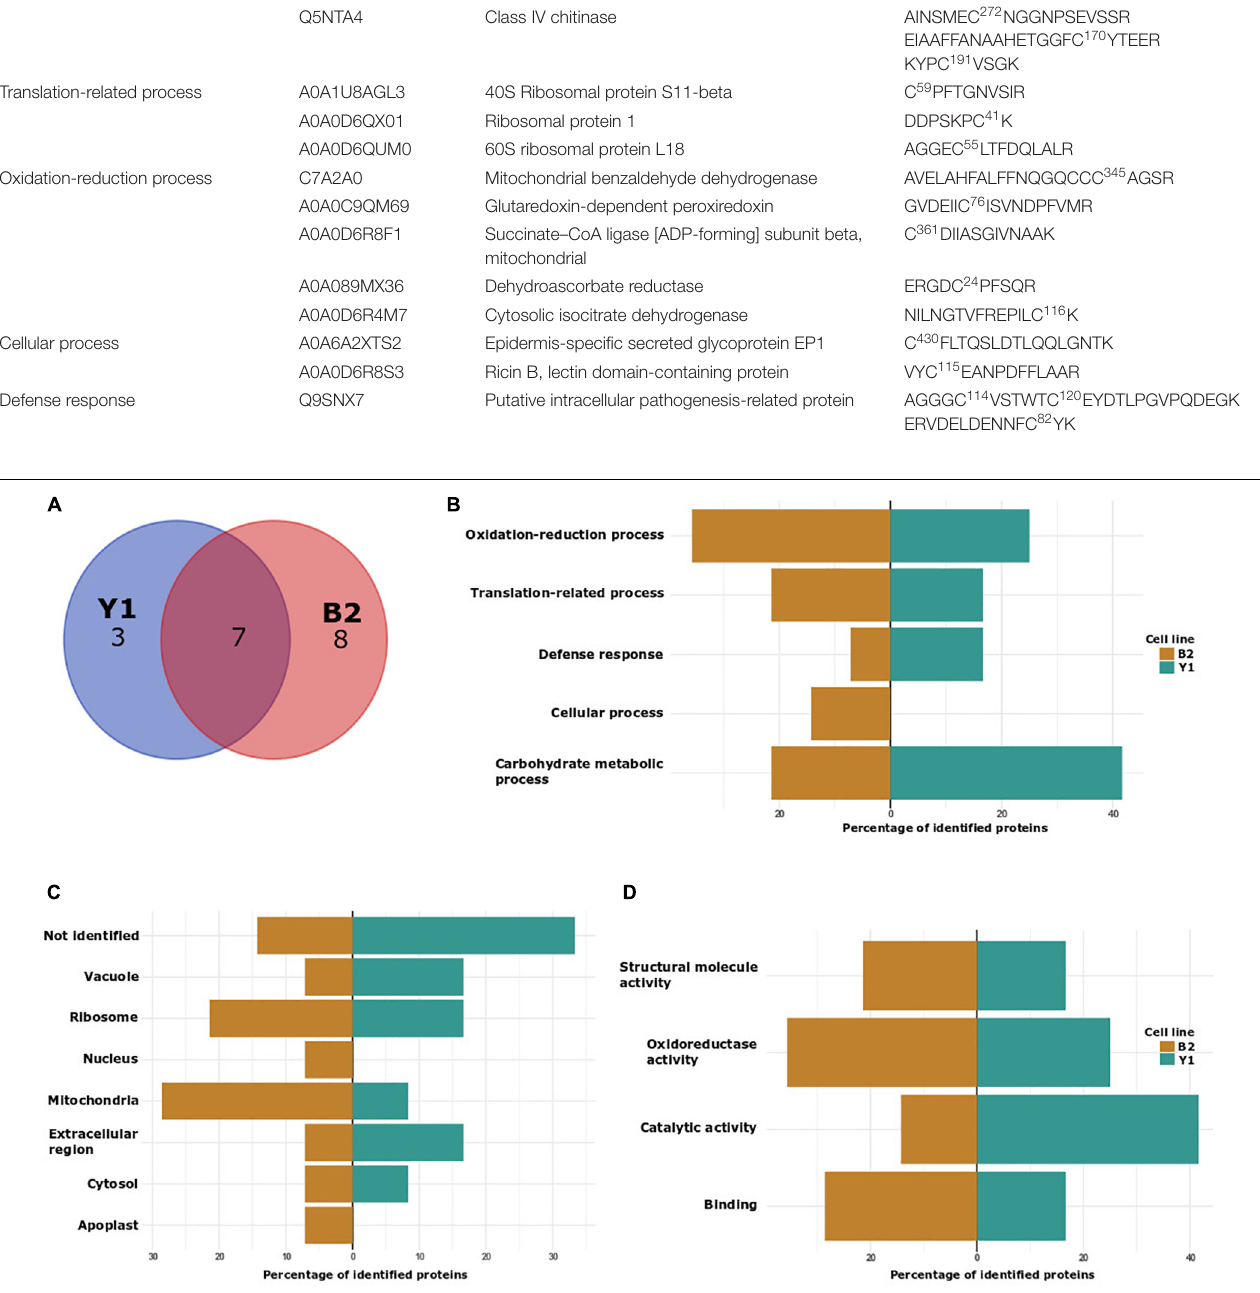
Frontiers in Plant Science |